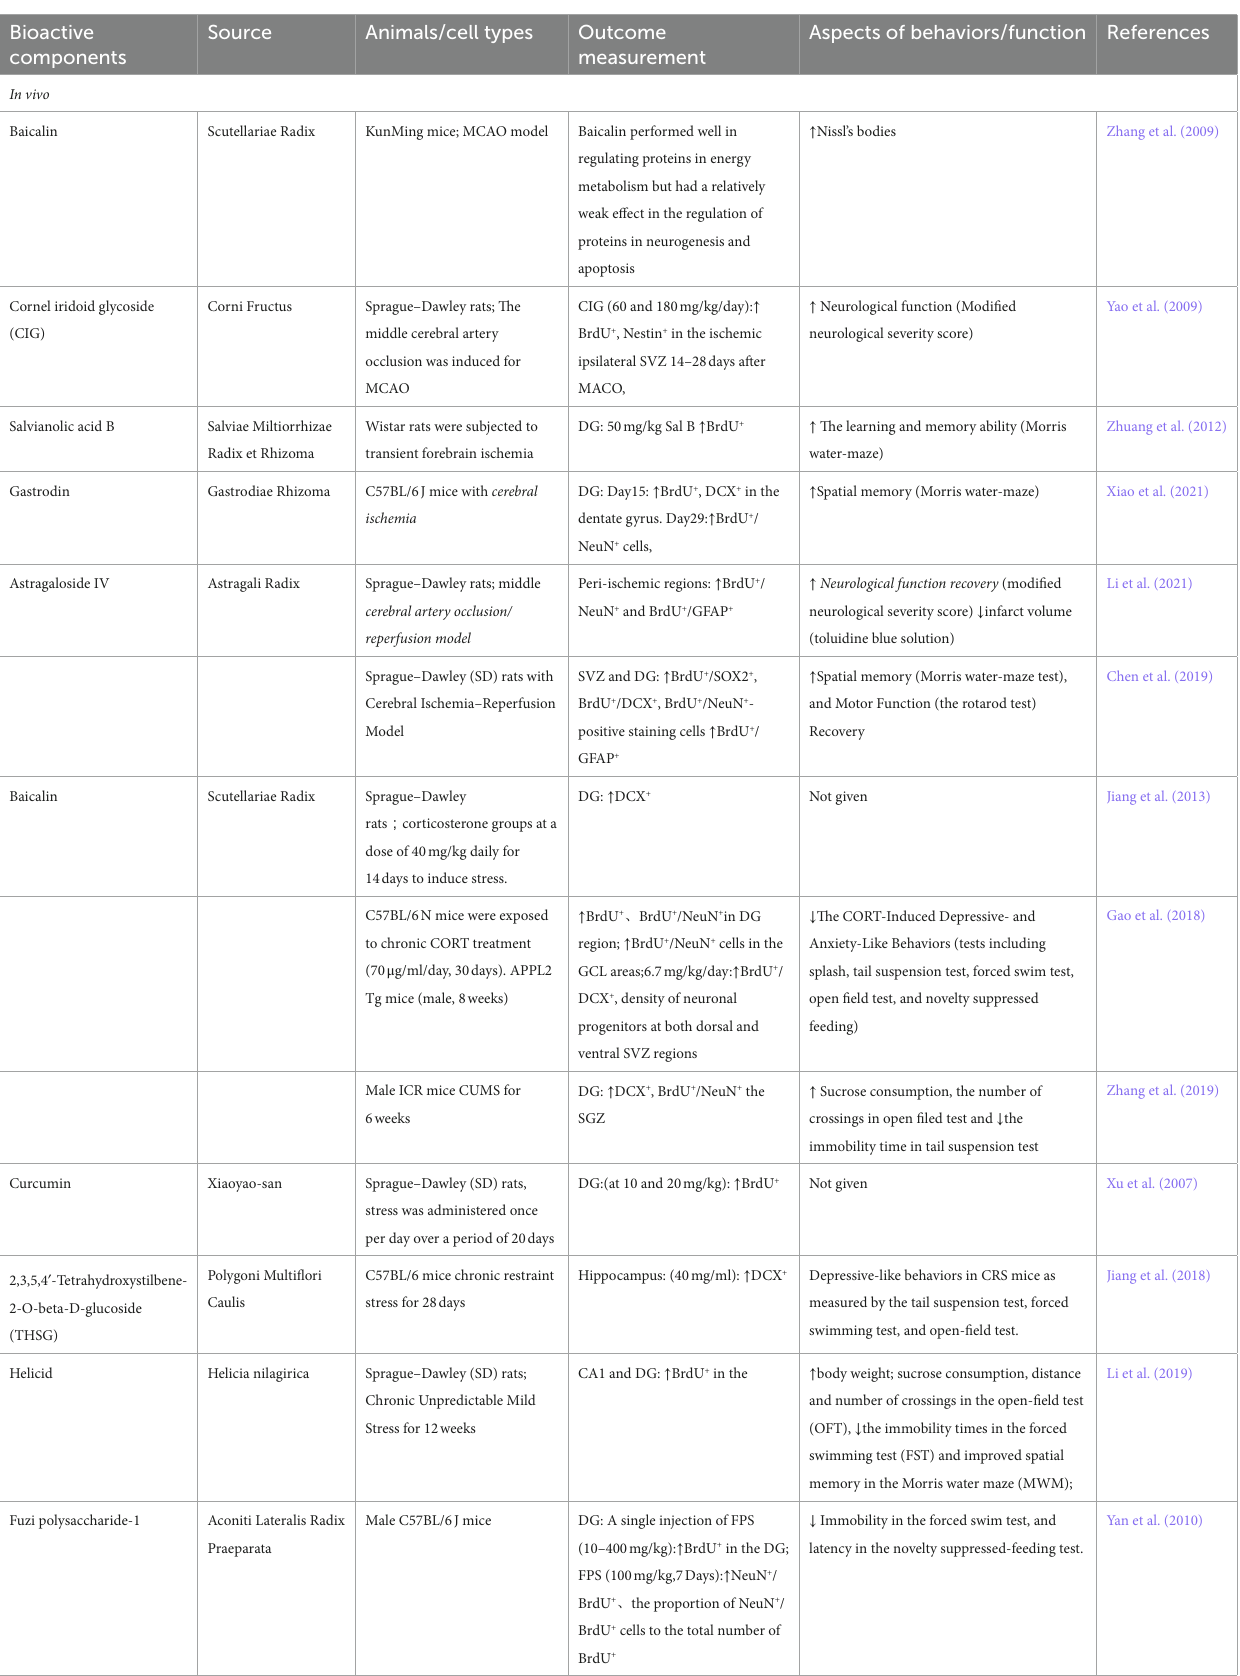
TABLE 3 The bioactive components of neurological conditions and adult